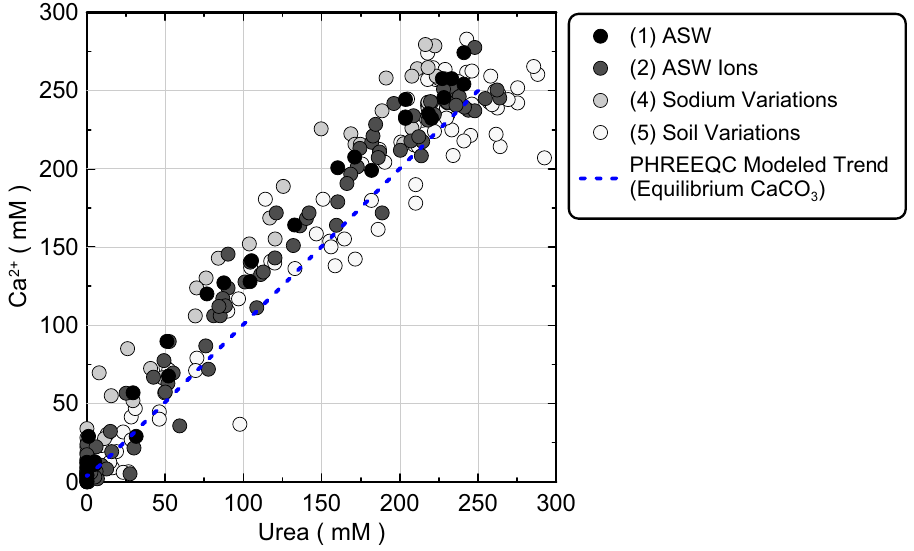
Figure 13. Corresponding measurements of aqueous Ca 2+ and urea concentrations from all experiments as well as a PHREEQC modeled trend which assumes CaCO 3 precipitation to be an equilibrium